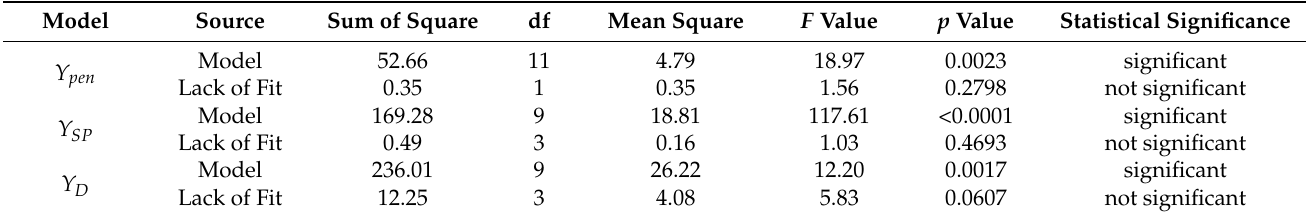
Table 4. Variance analysis of the physical performance fitting